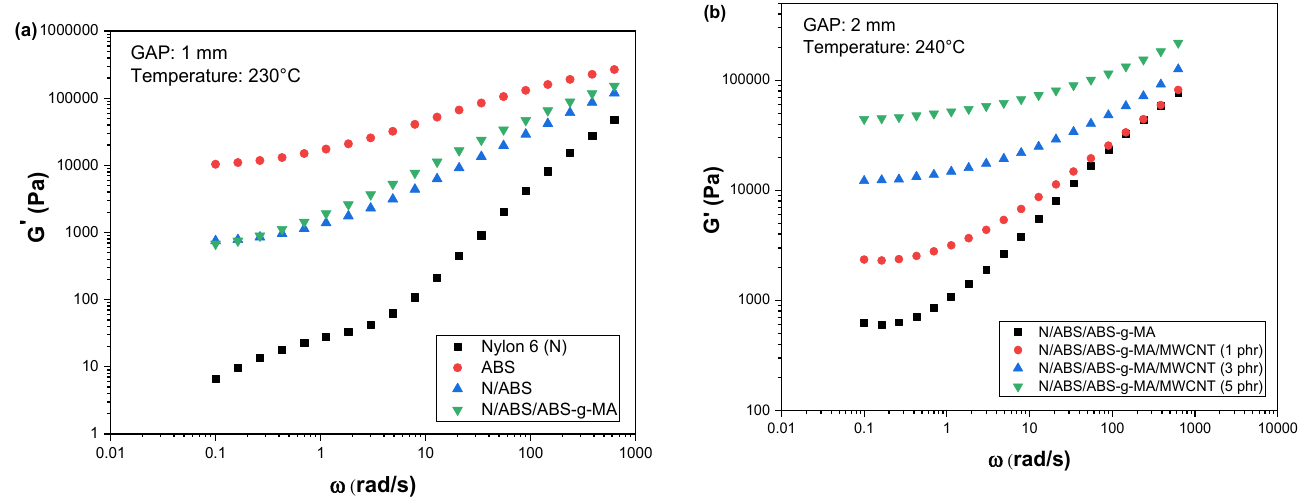
Figure 2. Storage modulus curves of Nylon 6, ABS, blends, and nanocomposites. ( a ) Nylon 6, ABS and blends; ( b ) Nylon 6/ABS/ABS-g-MA blend and nanocomposites with different MWCNT contents; N = Nylon